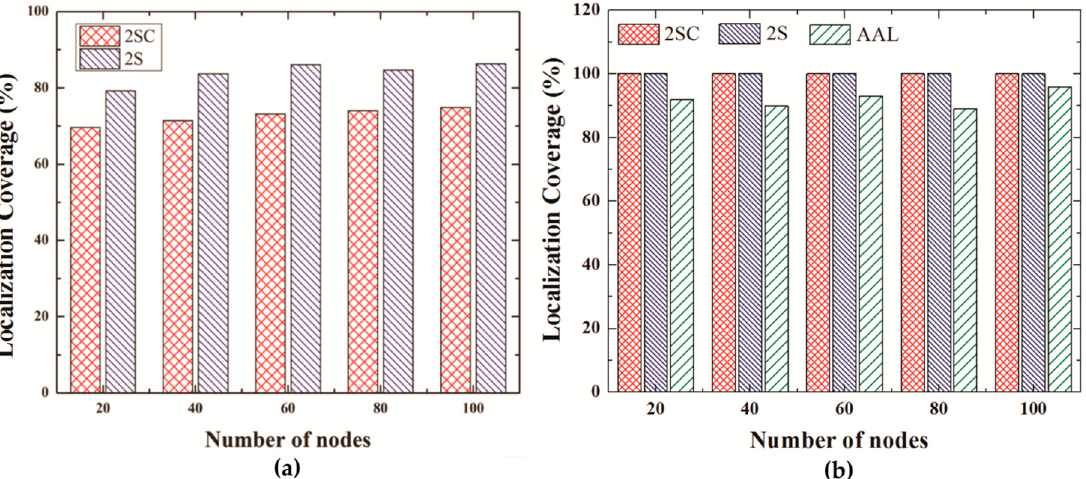
Figure 9. ( a ) Localization error for No. of iterations = 2. ( b ) Localization error for No. of iterations= 3(2S, 2SC), AUV Aided Localization.